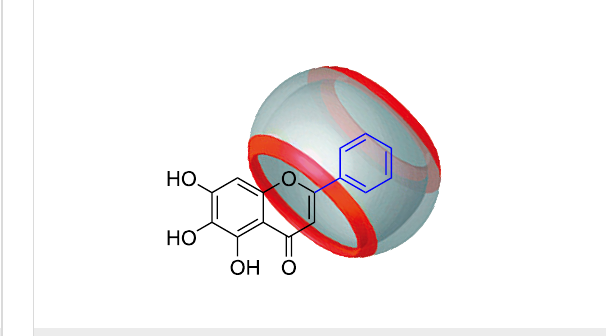
Figure 2: The possible interaction model for Q[8] and baicalein.